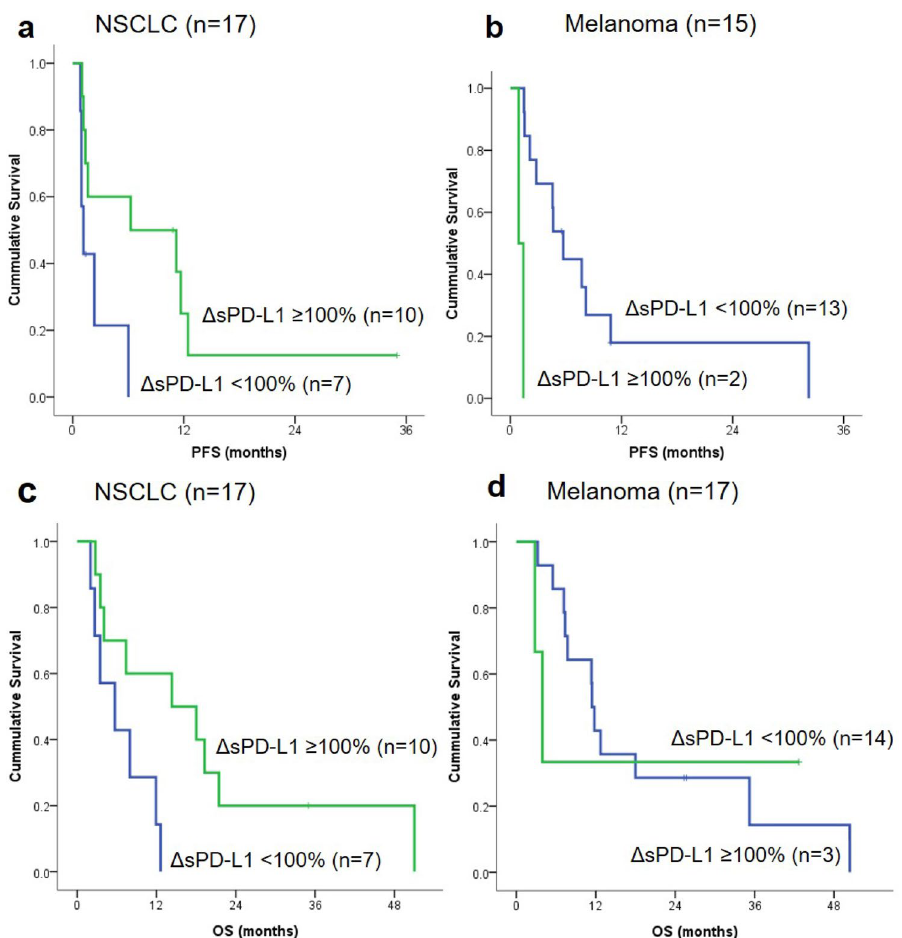
Figure 3. Kaplan–Meier curves for progression-free survival and overall survival in patients with NSCLC ( a , c ) and patients with melanoma ( b , d ) stratified by soluble programmed death ligand 1 levels. NSCLC non-small cell lung cancer, ΔsPD-L1 change in sPD-L1 concentration between pretreatment and posttreatment sampling, PFS progression-free survival, OS overall survival.